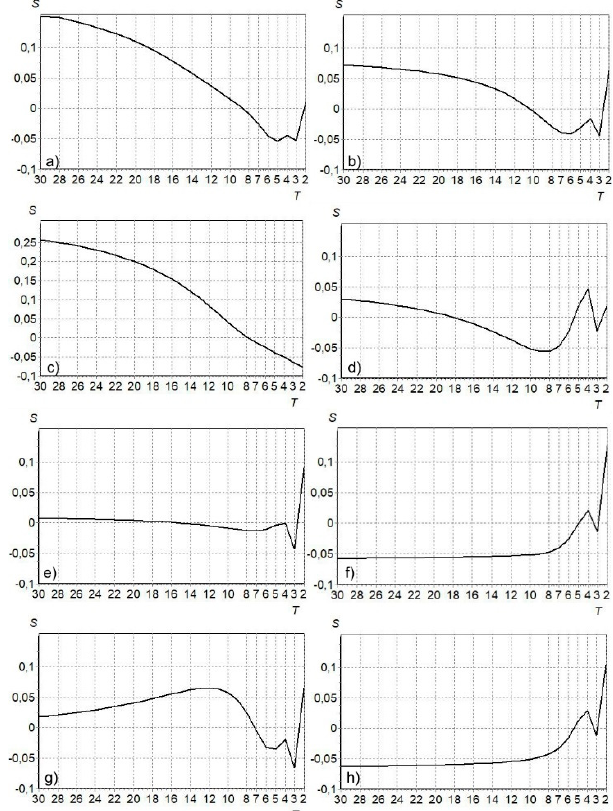
Figure 5. Monthly spectra of water and air temperature for the Oder and Neman Rivers – example for May: ( a , b ) Odra (Brzeg)-Opole, ( c , d ) Odra (S ł ubice)-Gorzów Wlkp, ( e , f ) Niemen (Grodno)-Grodno, ( g , h ) Niemen (Smalininkai)-Raseiniai.